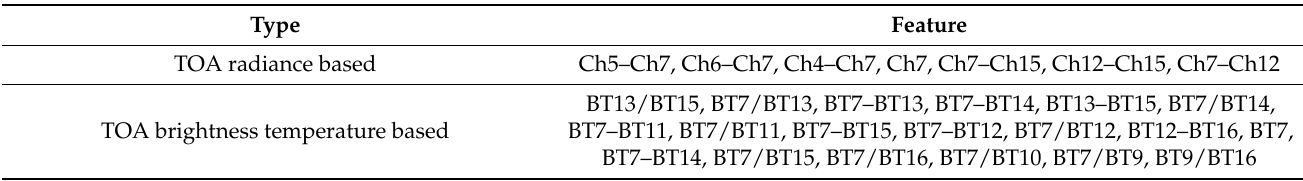
Table 3. The 26 features suggested by Jang et al. [17]. Chx is the TOA radiance of AHI band x, and BTx is the TOA brightness temperature of AHI band x.